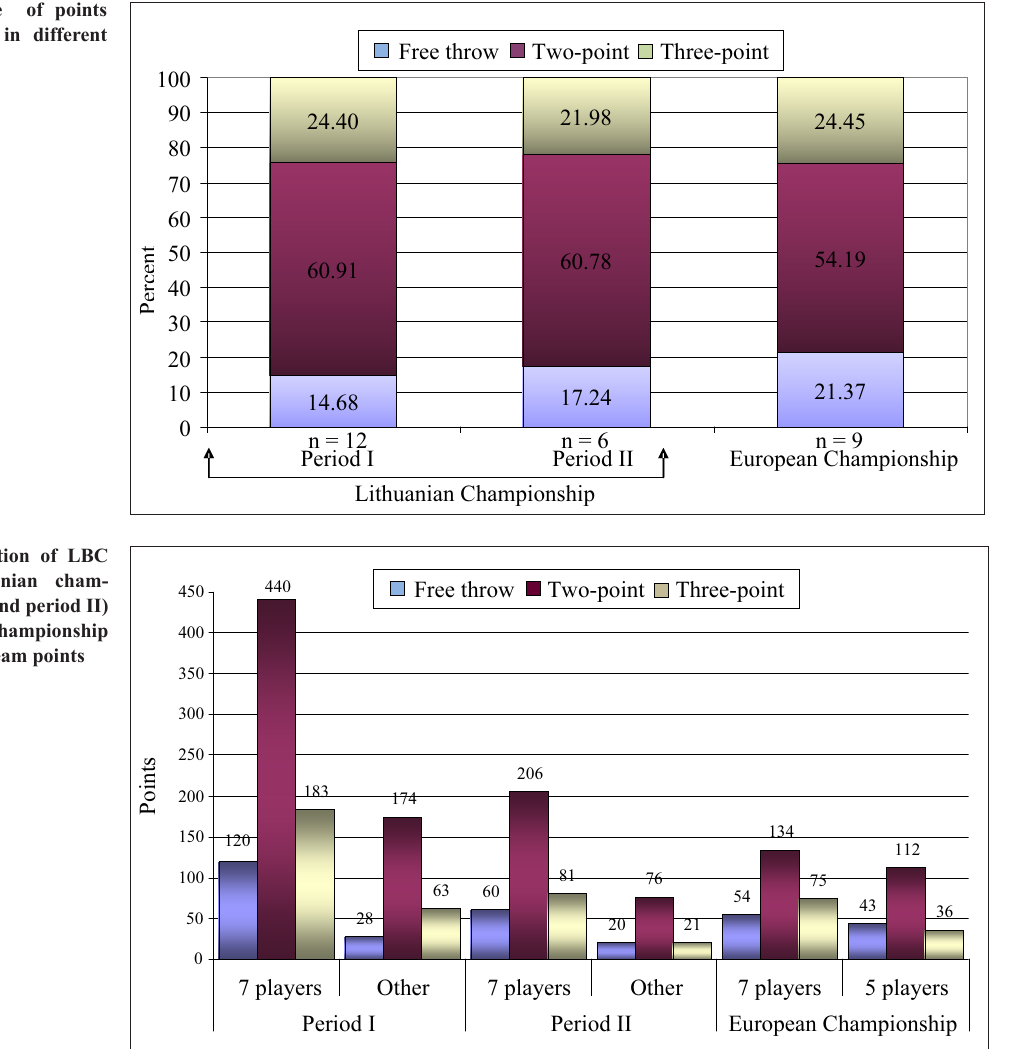
Figure 3. Structure of points scored per match in different competition ranks